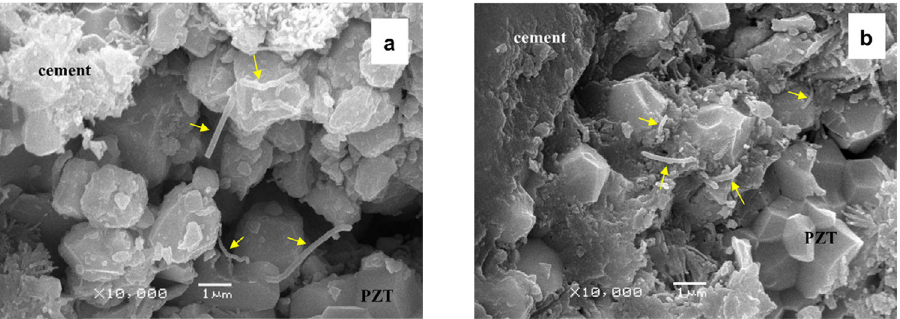
Figure 14: Conductive pathway constructed by CNT nano fi bers in PCM matrix ( yellow arrows are CNT ) : ( a ) bridging fi bers between cracks; ( b ) pull - out fi bers from PCM matrix ( yellow arrows are CNT ) [ 85 ]